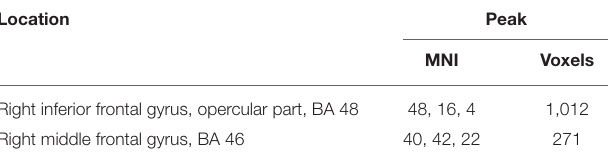
TABLE 5 | Brain regions engaged during timing and oddball detection